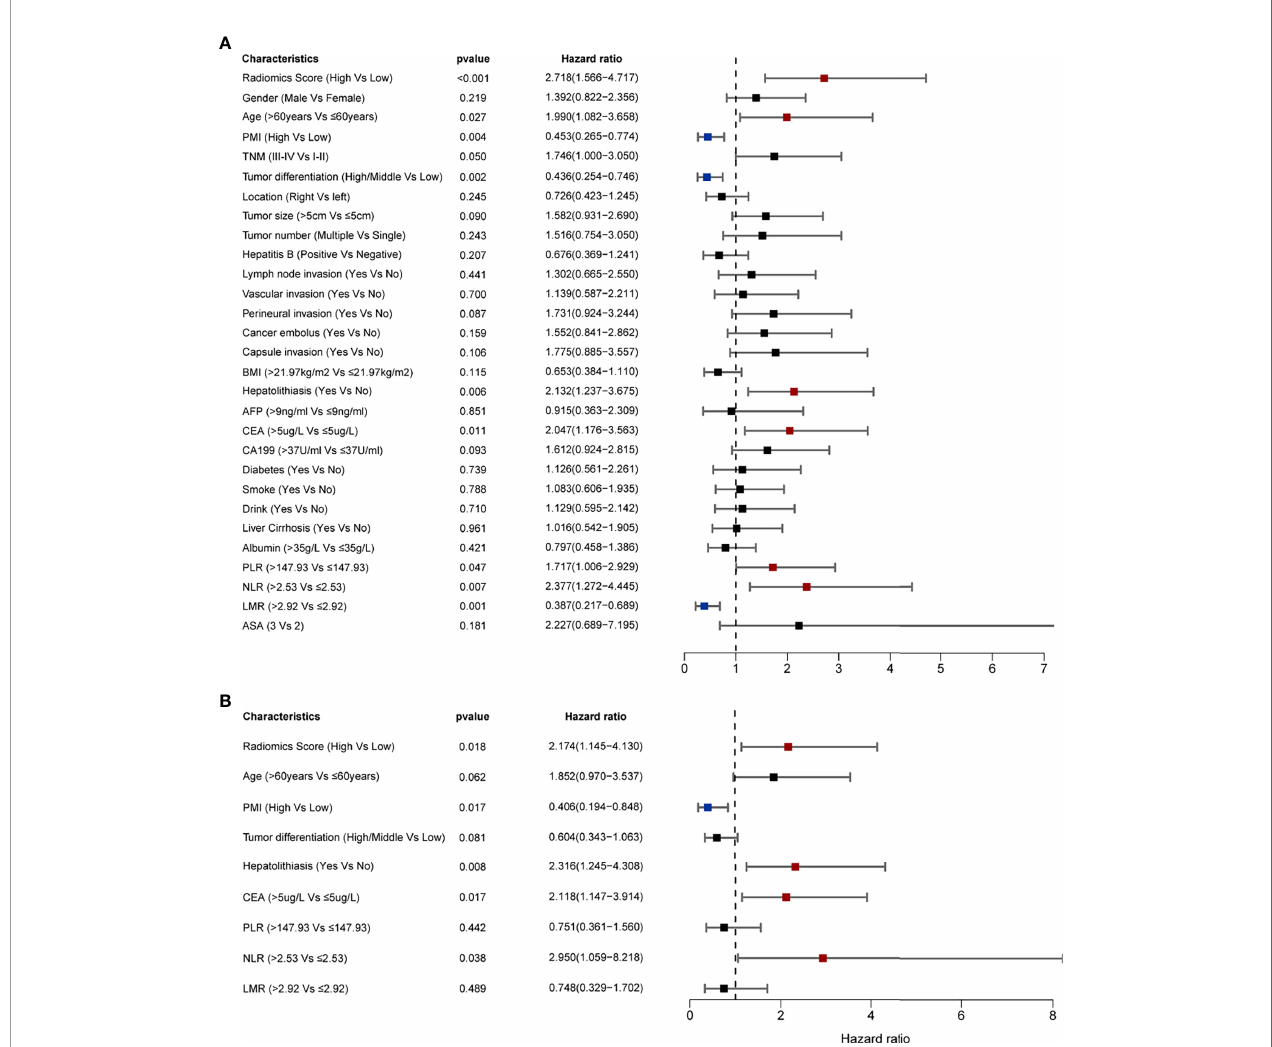
FIGURE 4 | Prognostic factors of OS identi fi ed by univariable and multivariable Cox regression analyses. (A) Univariable analyses identi fi ed the factors of OS ( p < 0.05). (B) Multivariable analyses identi fi ed the factors of OS ( p <